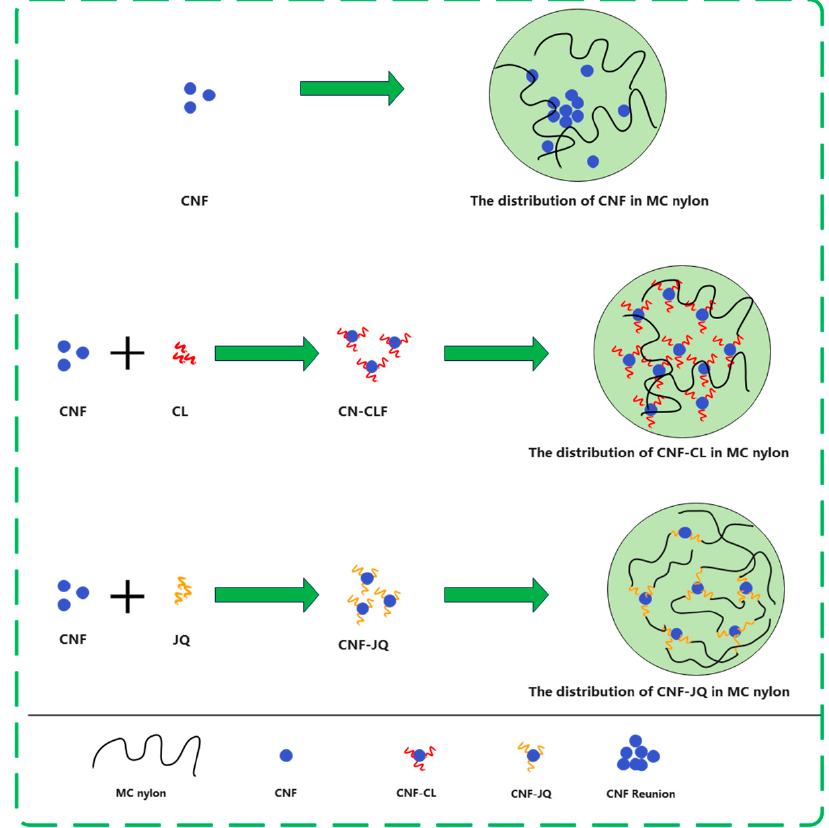
Figure 10. Dispersion mechanism of modified CNF in MC nylon matrix.